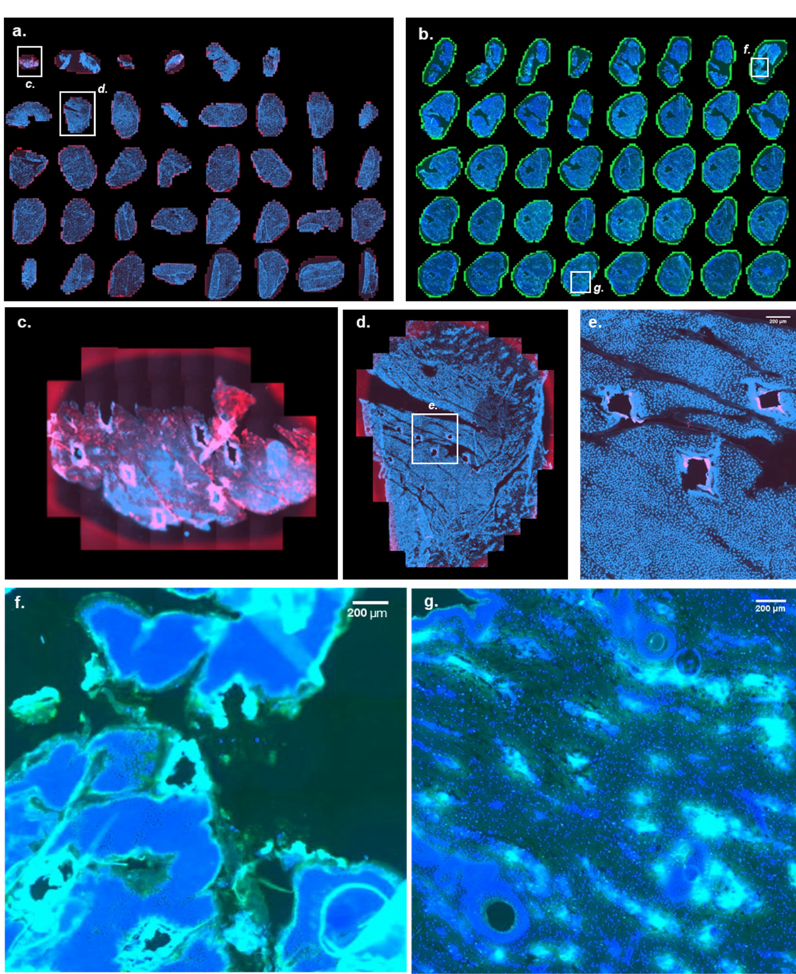
Figure 6. Cutaneous distribution as a function of depth of Cy5 labeled mRNA and eGFP after delivery of the former and eGFP expressing mRNA upon application to the skin surface after Er:YAG fractional laser ablation. The images show the Cy5 labeled mRNA (red), eGFP (green), and DAPI (blue) signal 24 h after delivery of the polymer formulations containing 1 µg of either Cy5 labeled mRNA or eGFP expressing mRNA into skin after fractional laser ablation. ( a , b ) are images of the Cy5 labeled mRNA and eGFP signals going from a skin depth of 10 to 400 µm after delivery of either the Cy5 labeled mRNA or the eGFP expressing mRNA. Laser-assisted drug delivery is a two-step process with the formulation being applied to the skin surface after fractional laser ablation. Unlike the other technologies, mRNA delivery and deposition are not targeted to the dermis. Hence, the presence of Cy5 labeled mRNA and eGFP in the upper epidermis is to be expected. ( c ) Close-up image of the Cy5 labeled mRNA signal from the uppermost epidermal region—section 1, corresponding to a depth of 10 µ m. ( d ) Closer view of the lower epidermal region—section 10, corresponding to a depth of 10Im. ( e ) Increased magnification of the micropores created by fractional laser ablation present in section 10, at a depth of 100 µ m. The Cy5 labeled mRNA signal is localized around the micropores. ( f ) eGFP expression around the micropores in the epidermis (section 8, corresponding to a depth of 80 µ m) and ( g ) eGFP expression in the dermis (section 36, corresponding to a depth of 360 µ m) confirms that the eGFP expressing mRNA was able to diffuse away from the micropores to the sites of protein expression in the dermis. For panels ( a , b ), high resolution images are available in Supplementary Materials—File S3—high resolution montages of all 40 skin